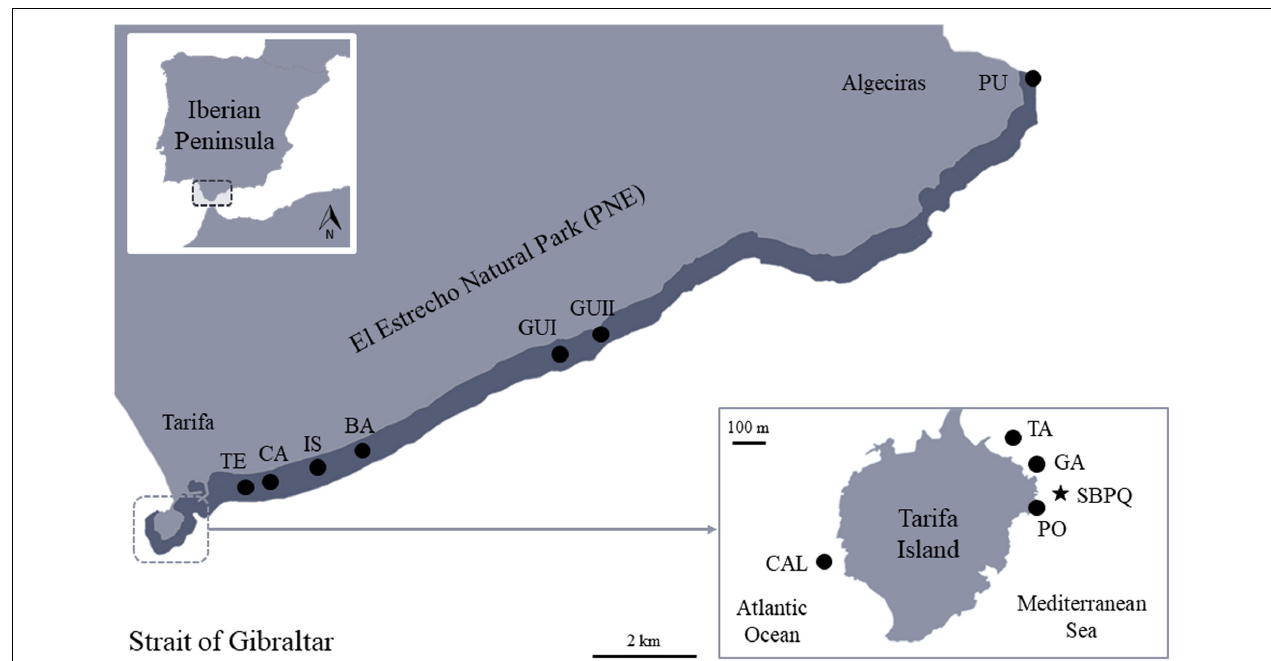
FIGURE 1 | Location of the study area in the Strait of Gibraltar showing the different sampling stations for each research objective. Star: location of the SBPQ station in the Tarifa Island; Dark band: eastern littoral of El Estrecho Natural Park (PNE) subjected to estimations of R. okamurae coverage-affections; Black points: sampling stations for Citizen Science collaborations. CAL = Caldera Profunda; TA = Tanque Gasoil; GA = La Garita; PO = Pozas Intermareales; TE = El Tejar; CA = La Caleta; IS = La Isleta; BA = Barranco Hondo; GUI = Guadalmesí I; GUII = Guadalmesí II; PU = Punta